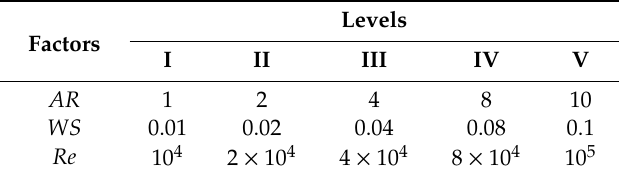
Table 1. Description of parameter levels designed for this